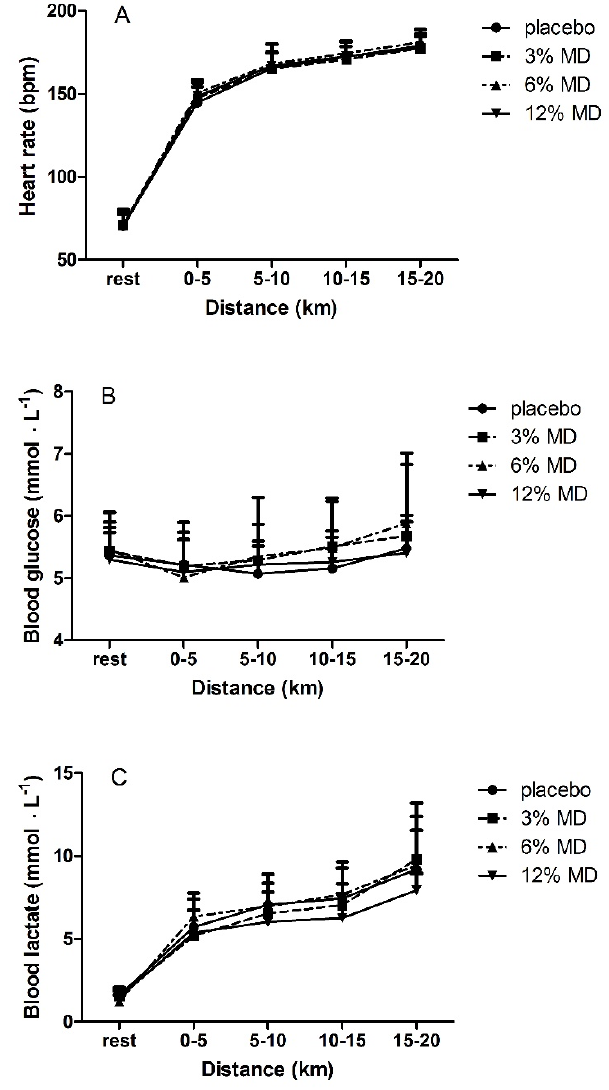
Figure 3. Heart rate ( A ); blood glucose ( B ); and blood lactate ( C ) as a function of cycled distance. MD, maltodextrin.